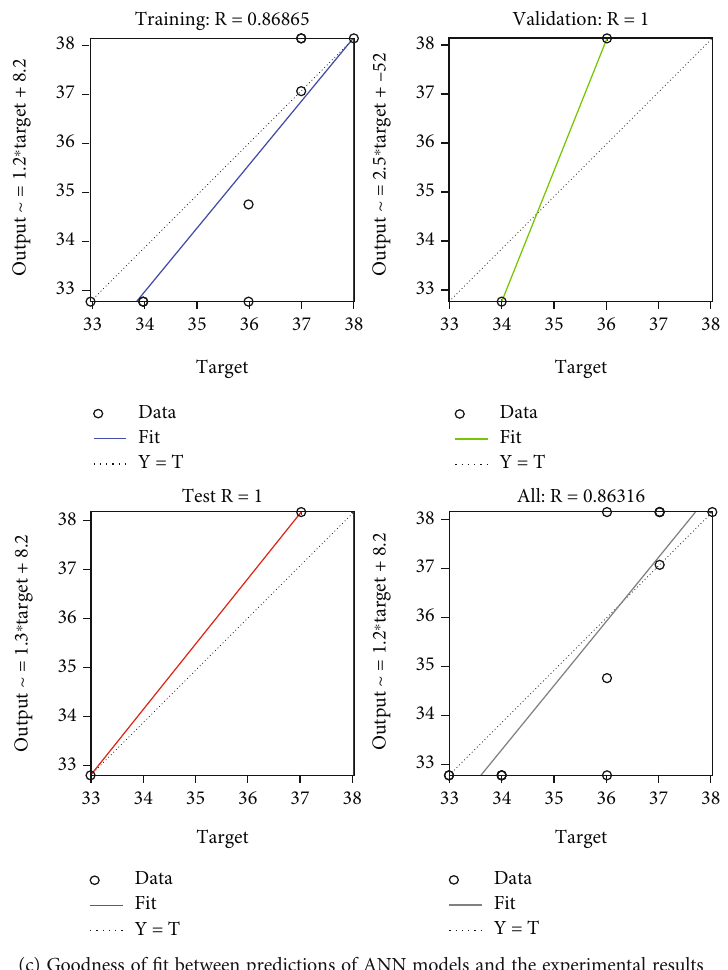
Figure 7: Neural network training regression